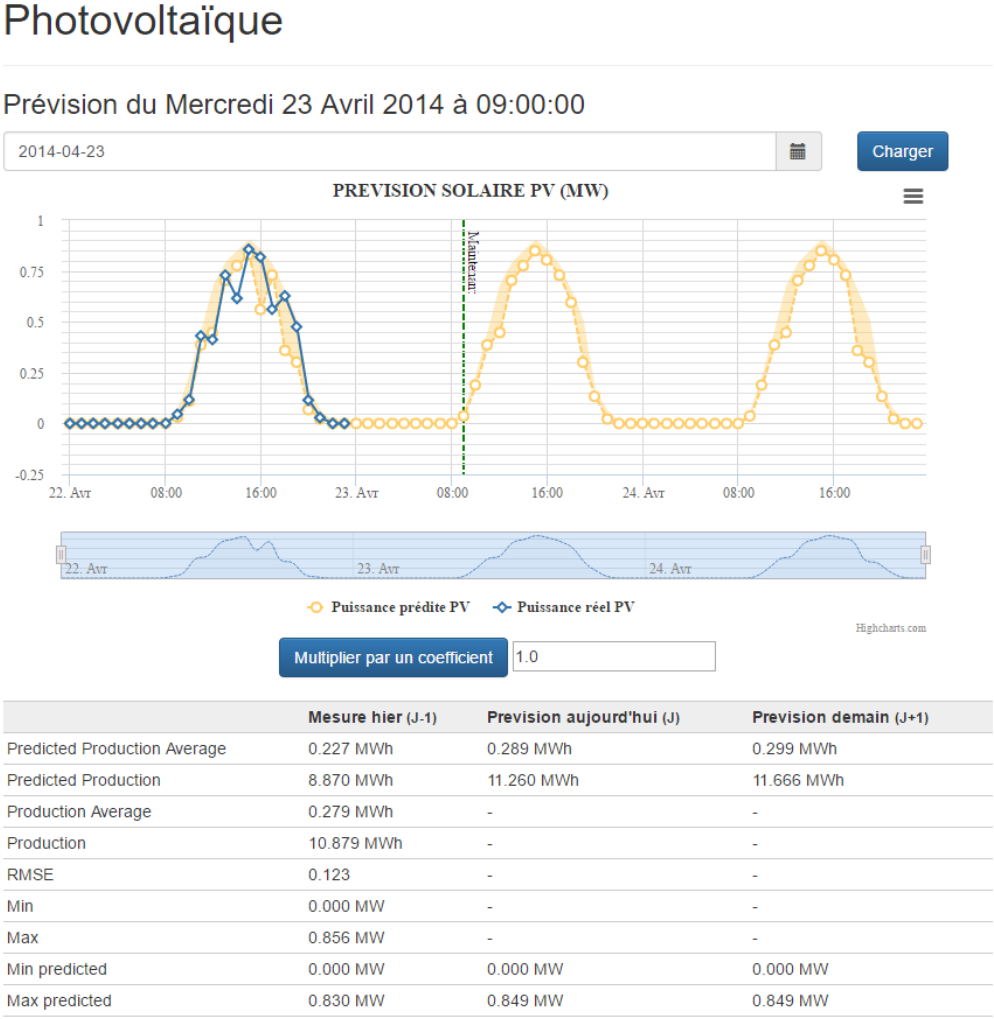
Figure 9. Photovoltaic prediction.